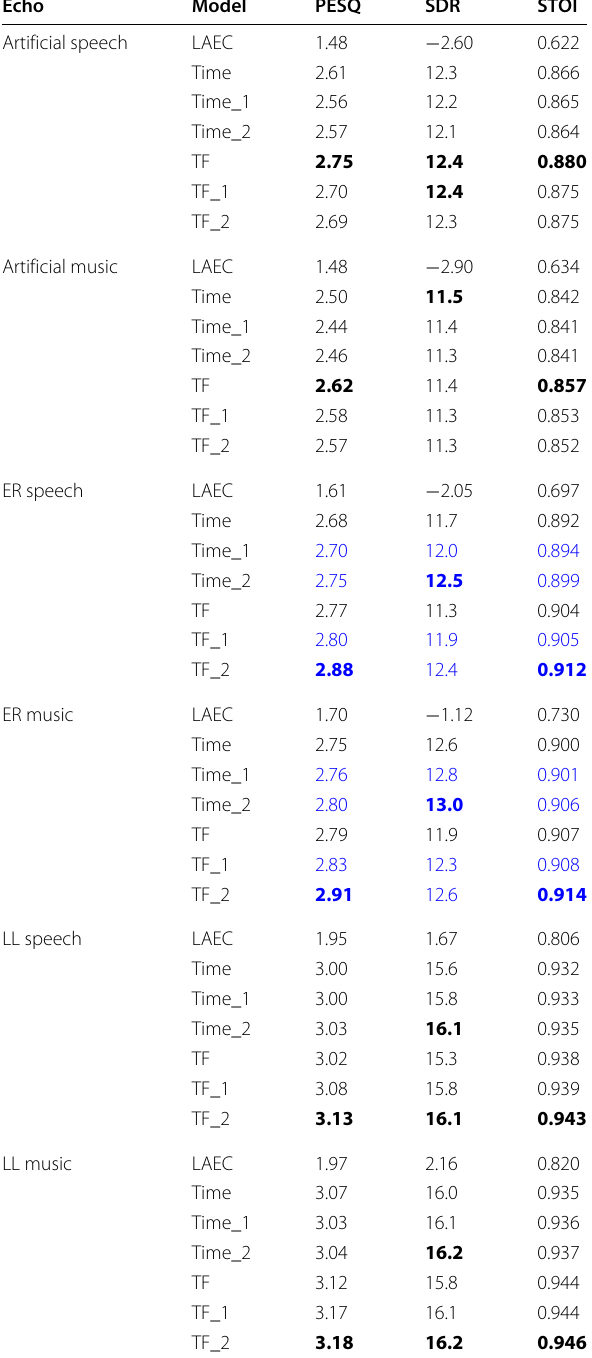
Table 3 Performance of the pre-trained model and the fine-tuned models with ER recorded